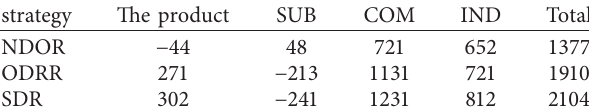
Table 4: Comparison of demand between SDR and other strategies.